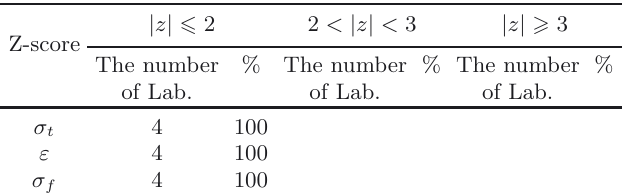
Table 6. Evaluated